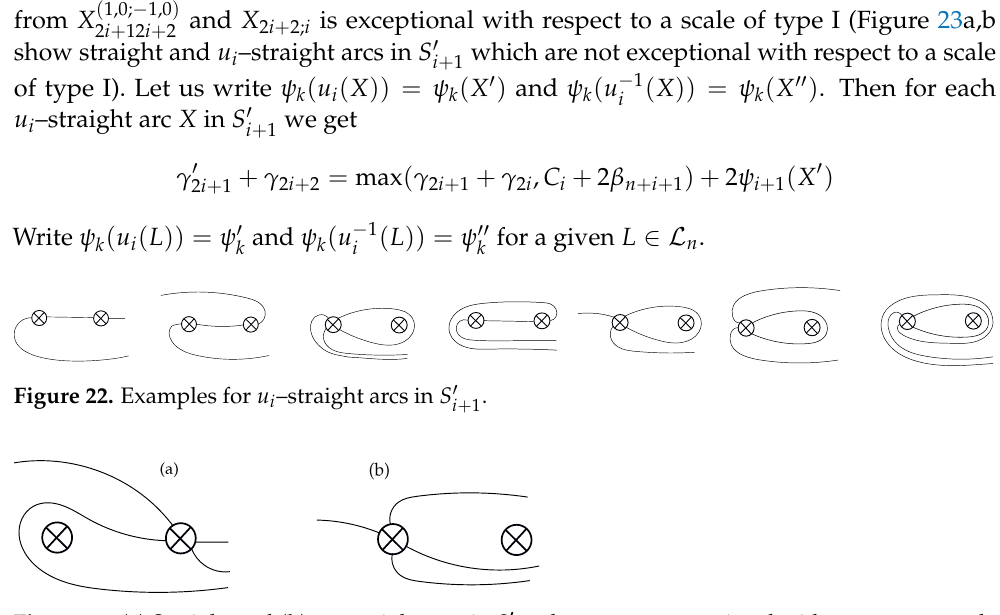
Figure 23. ( a ) Straight and ( b ) u i –straight arcs in S (cid:48) of type